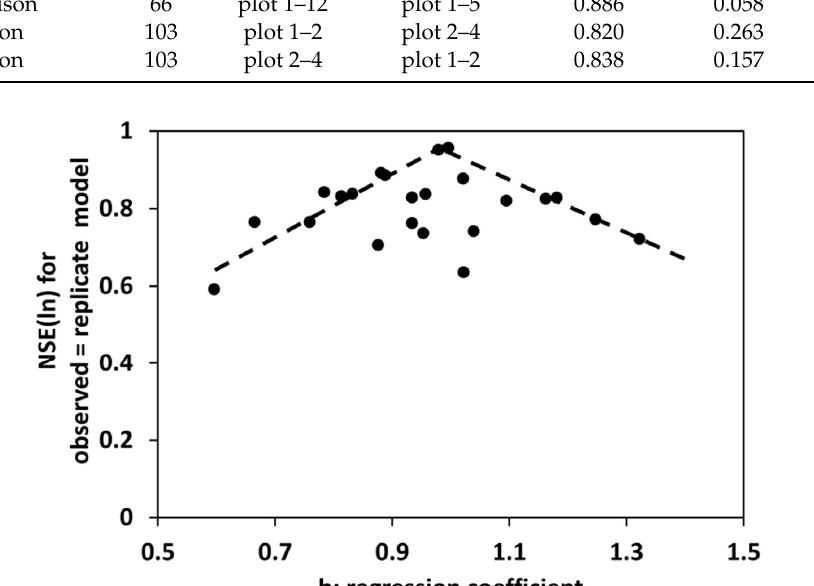
Figure 15. The relationship between b when the equation-observed event soil loss = b (replicate event soil loss) and NSE (ln) when the event soil loss = 1.0 (replicate soil loss) (source: Kinnell [63]).